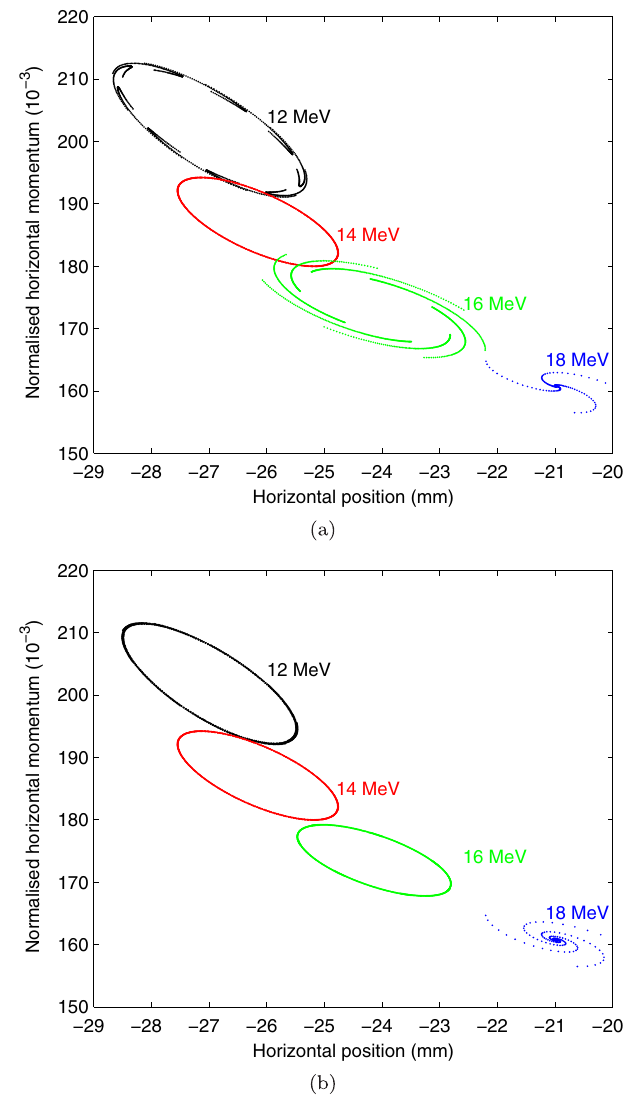
FIG. 9. Betatron motion for different energy deviations, simu- lated with a single transfer map up to (a) 7th order, and (b) 9th order. The reference energy is 14 MeV. We observe that for a map truncated at the 7th order, the betatron motion in horizontal phase space has a strong nonphysical growth in the amplitude for energy deviation (cid:2) 2 MeV . Improved behavior is obtained for energy deviation of (cid:2) 2 MeV by retaining terms up to 9th